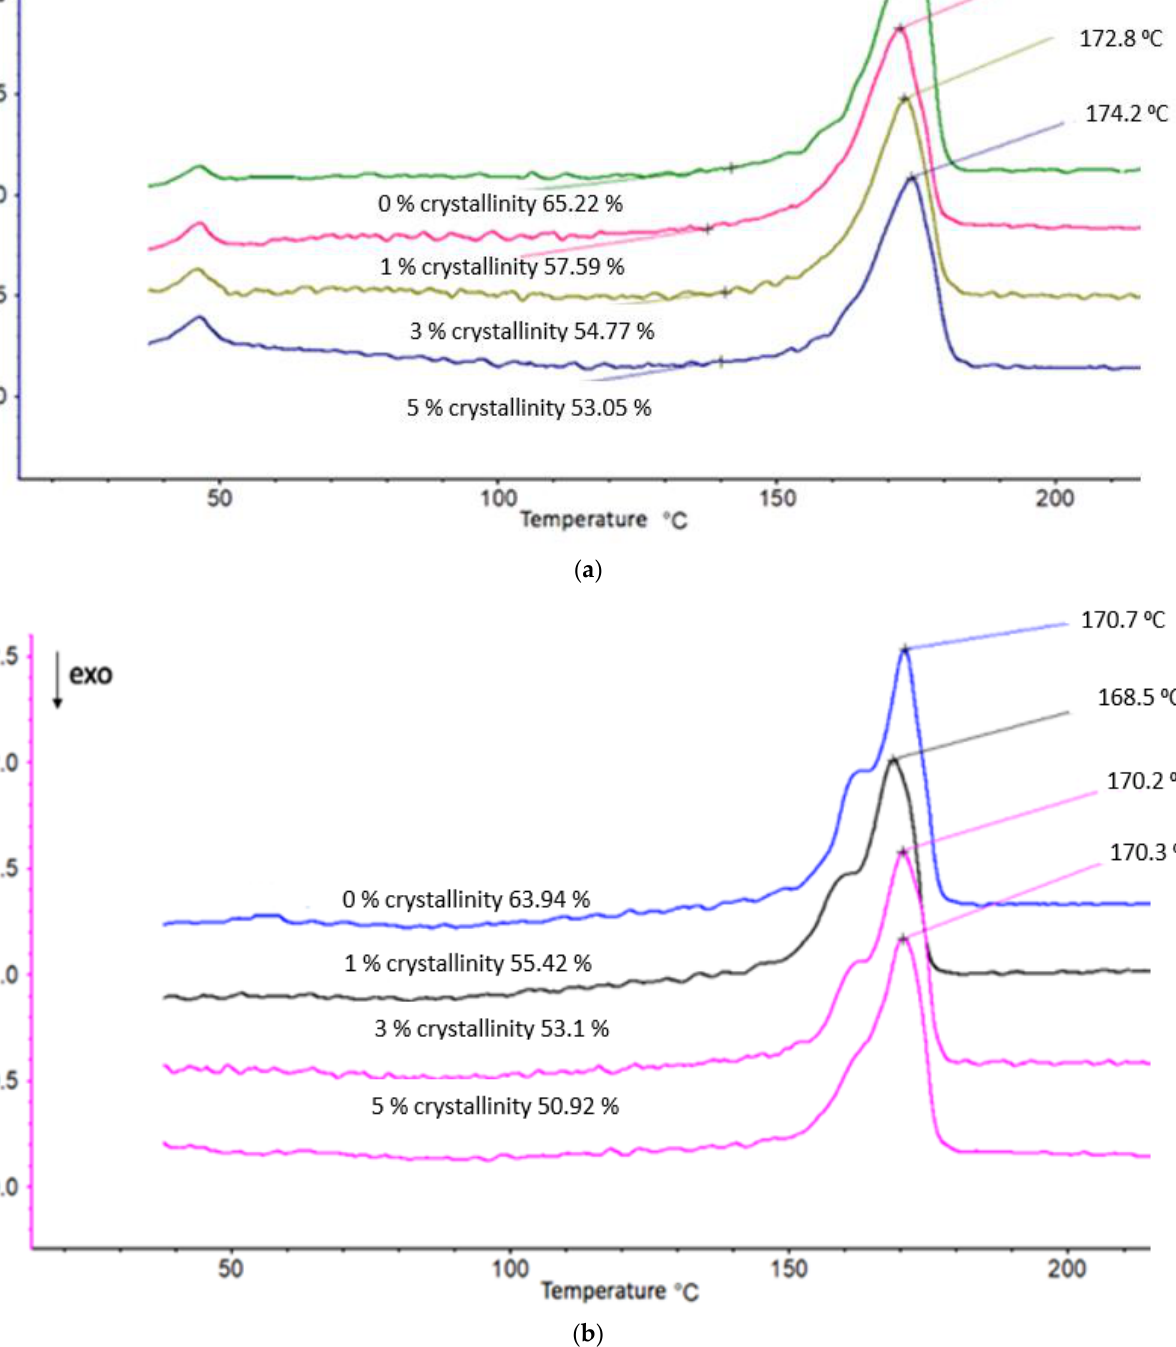
Figure 4. Thermograms of PHB/hemin melting ( a ) 1st and ( b ) 2nd scanning. The increase in ΔH in PHB fibers with hemin after exposure can be explained by the predominance of plasticization processes and, as a consequence, an increase in the pro- portion of straightened chains in the fiber and, upon longer exposure, the formation of hydrated complexes that loosened the structure of crystalline regions (end surfaces of